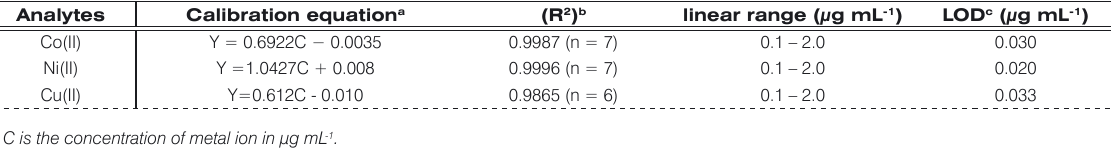
Table 1. Analytical characteristics for analysis of Co(II), Cu(II) and Ni(II) in ternary mixtures by PLS regression.